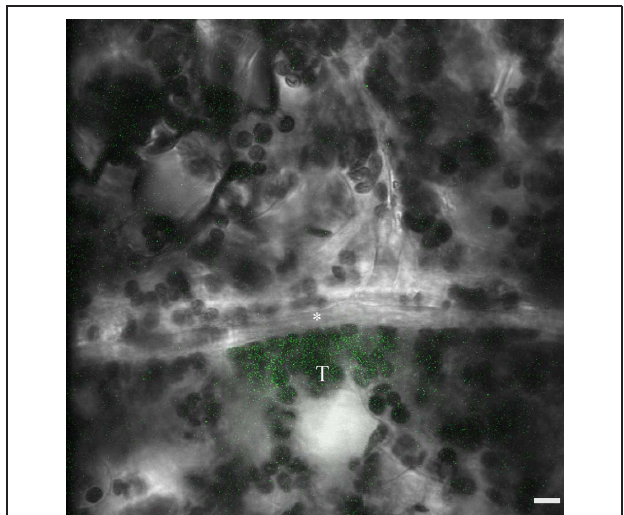
FIGURE A1 | Confocal image of a photoactivation experiment in a Cucurbita pepo leaf. The image shows a single optical section of a 30 μ m thick z-stack that was recorded at one time point during the 10s-long photoactivation phase. The fluorescence of the activated tracer is displayed as extended focus projection in green, overlaid over the brightfield image. In image analysis, three-dimensional regions of interest are drawn adjacent to the cell wall between the bundle sheath target cell (T) and the intermediary cell ( ∗ ) in order to quantify diffusion of activated tracer. Scale bar: 10 μ m.